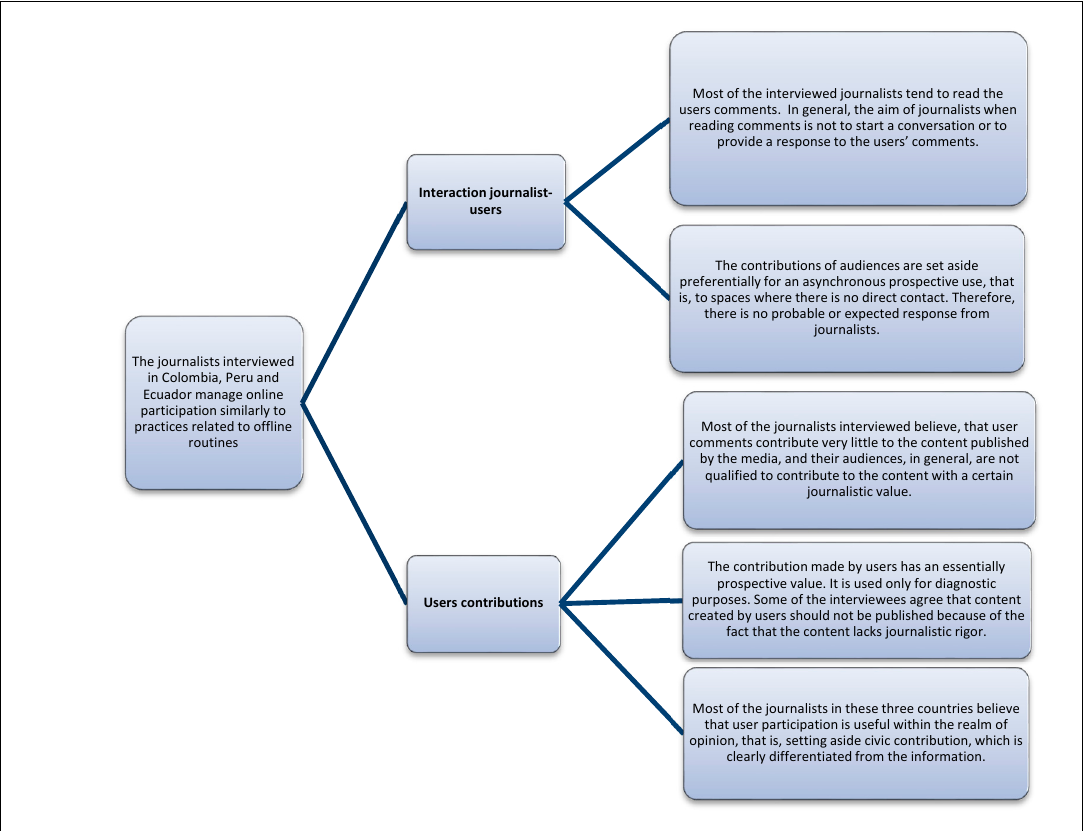
Figure 1. Interactive practices of the journalists interviewed in Colombia, Peru and Ecuador. ( Source: Created by the authors)